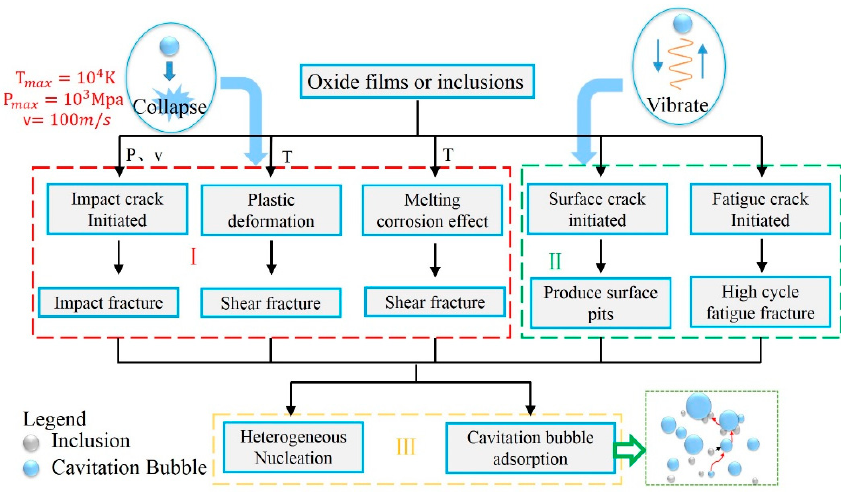
Figure 10. Mechanisms of ultrasonic cavitation on oxide inclusions.